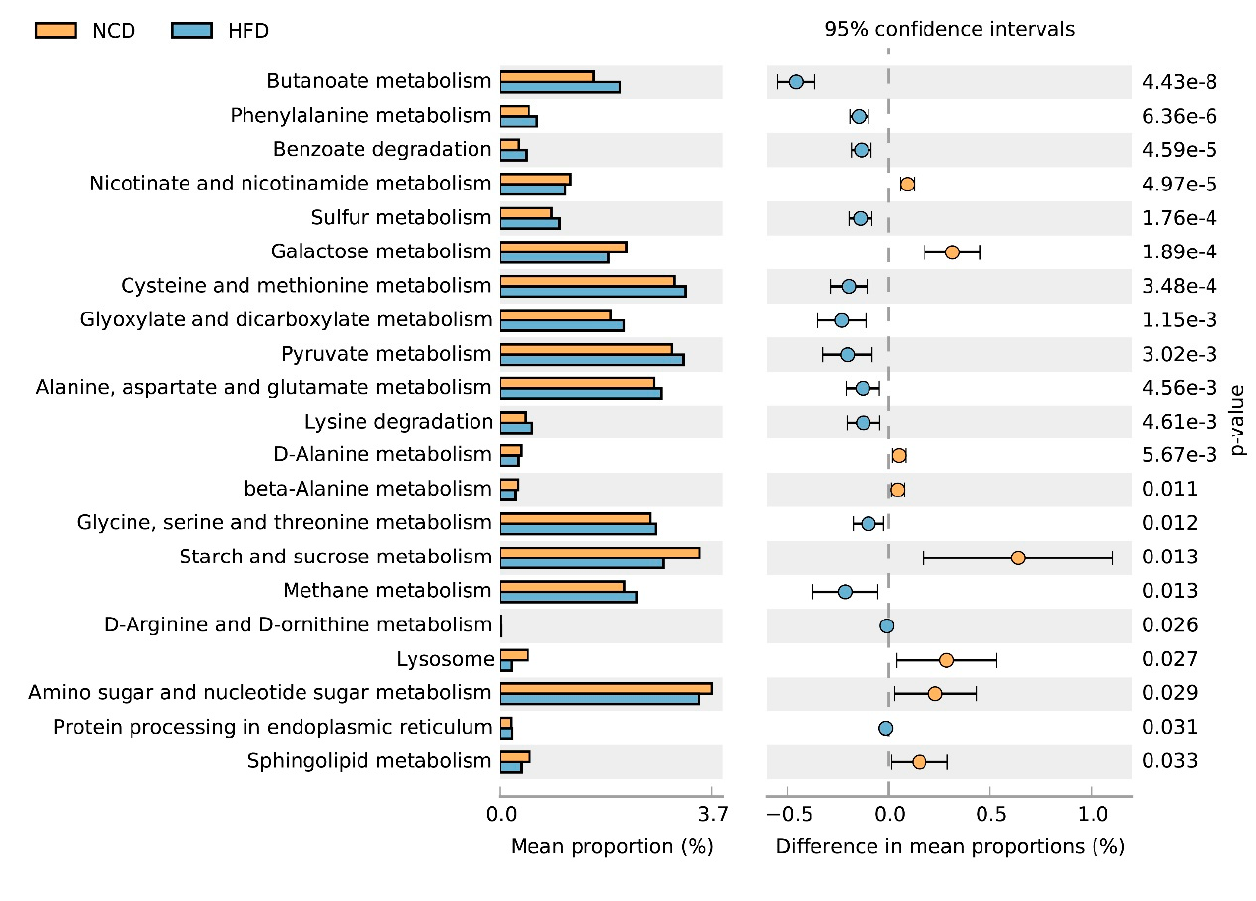
Figure 7. Key phylotypes of gut microbiota. ( A ) Cladogram generated from LEfSe analysis showing the relationship among tax- ons, and ( B ) linear discriminant analysis (LDA > 3) scores derived from LEfSe analysis.